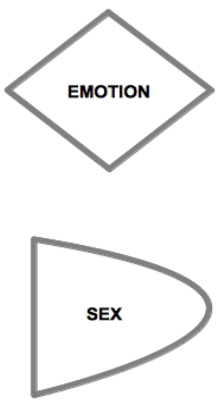
Figure 3. Emotional vs. sexual components.